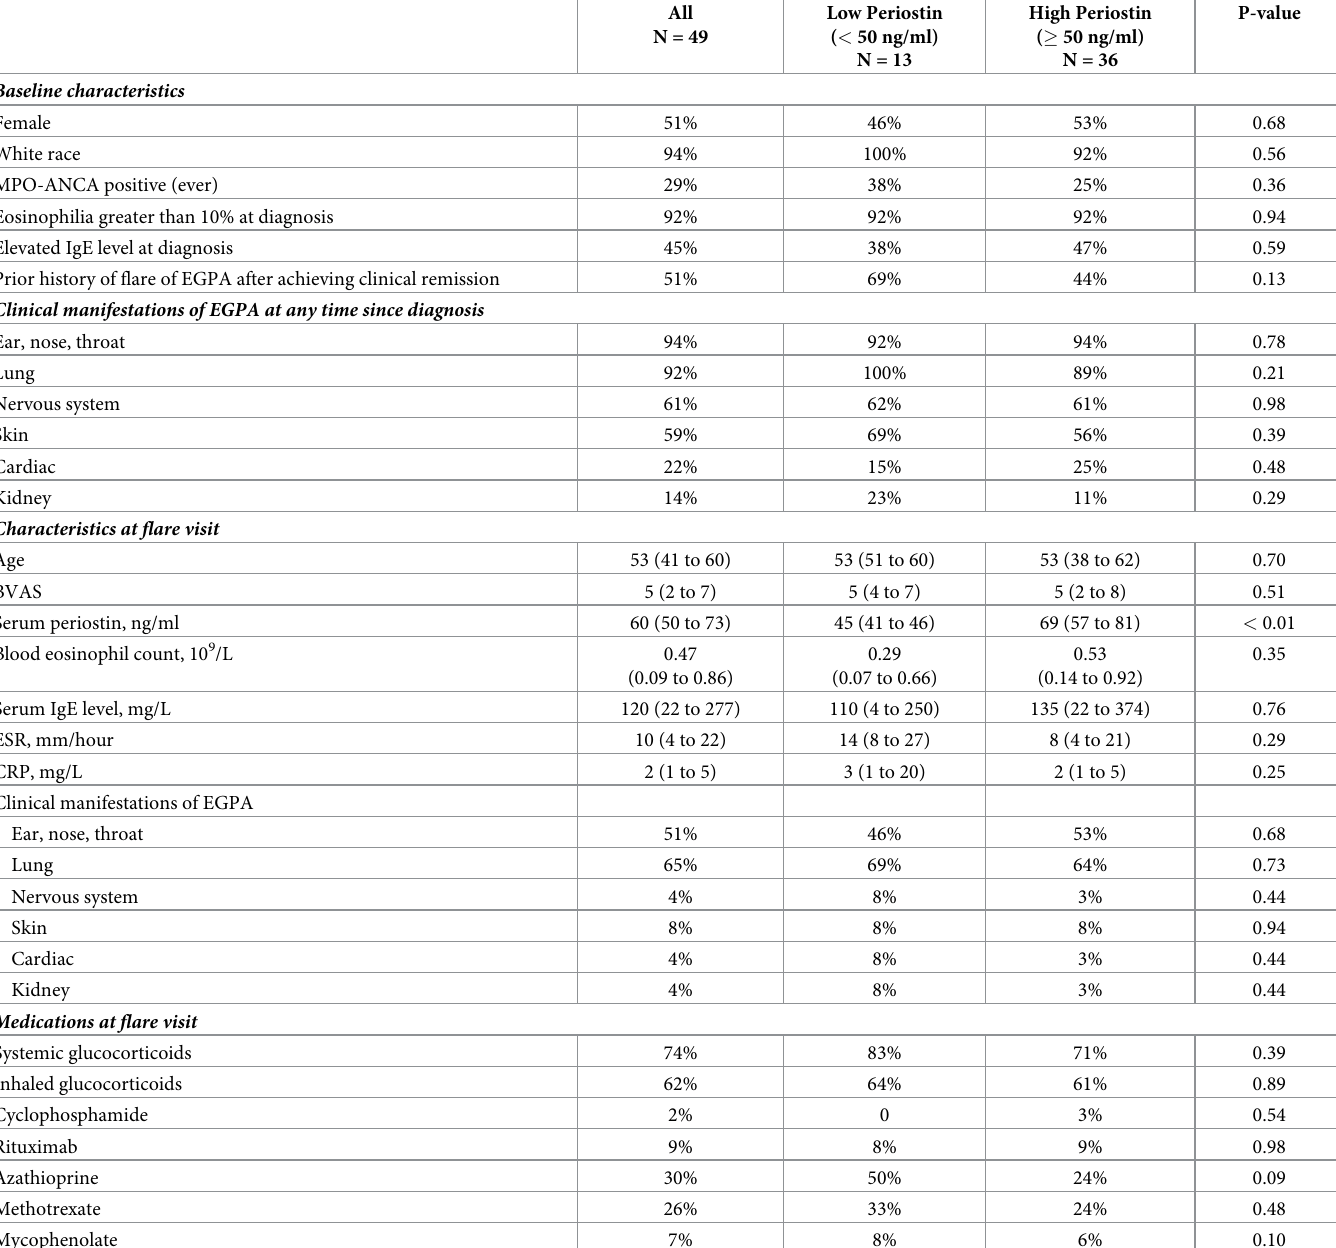
Table 1. Characteristics of study patients with eosinophilic granulomatosis with